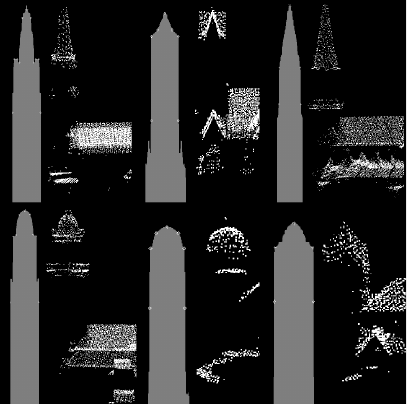
Figure 9: Estimated tower shapes in comparison with the original shapes in the point cloud